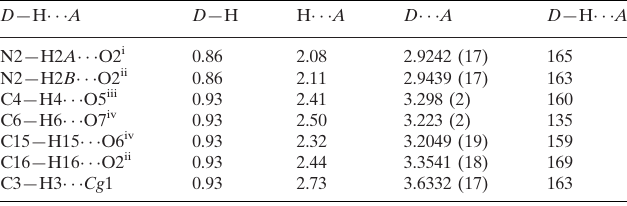
Hydrogen-bond geometry (A˚ , (cid:2)